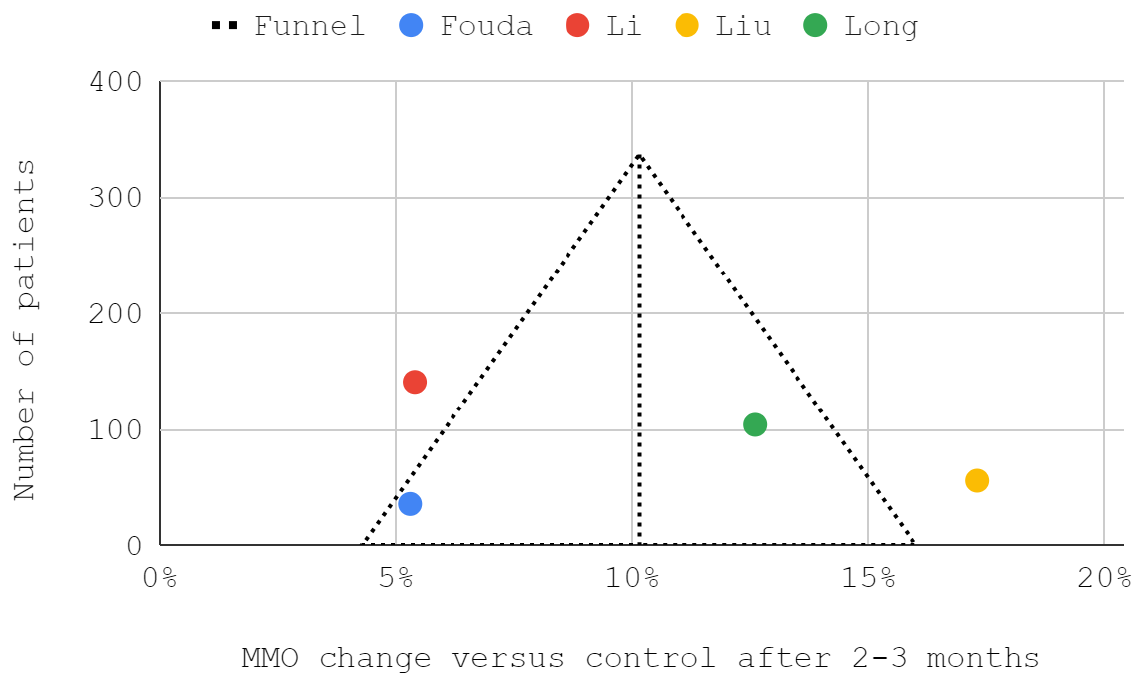
Figure 10. A funnel plot of the efficiency of inferior versus superior compartment TMJ treatment in maximum mouth opening (MMO) domain after 2 – 3 months.